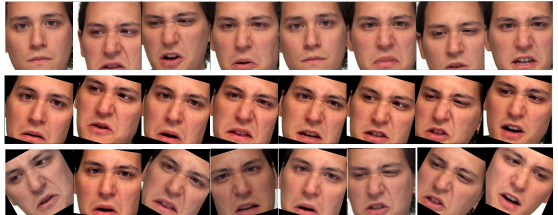
Figure 8. Visual comparison of augmentation procedure for cropped video frames. Top part : Original video frames. Middle part : Applying random augmentation parameters—same for all frames. Bottom part : Applying random augmentation parameters—different for each frame.